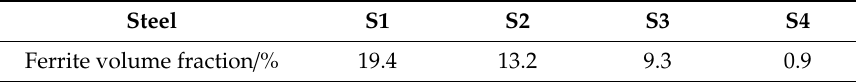
Table 5. The ferrite volume fraction of the tested steels at